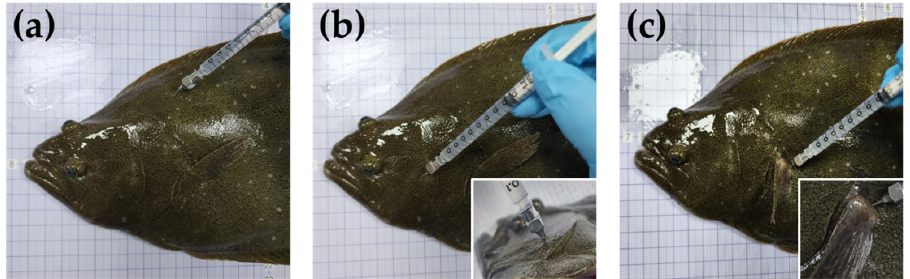
Figure 1. Representative photo describing the intramuscular injection sites of amoxicillin in olive flounder ( Paralichthys olivaceus ): ( a ) dorsal, ( b ) cheek, and ( c ) pectoral fin muscles.